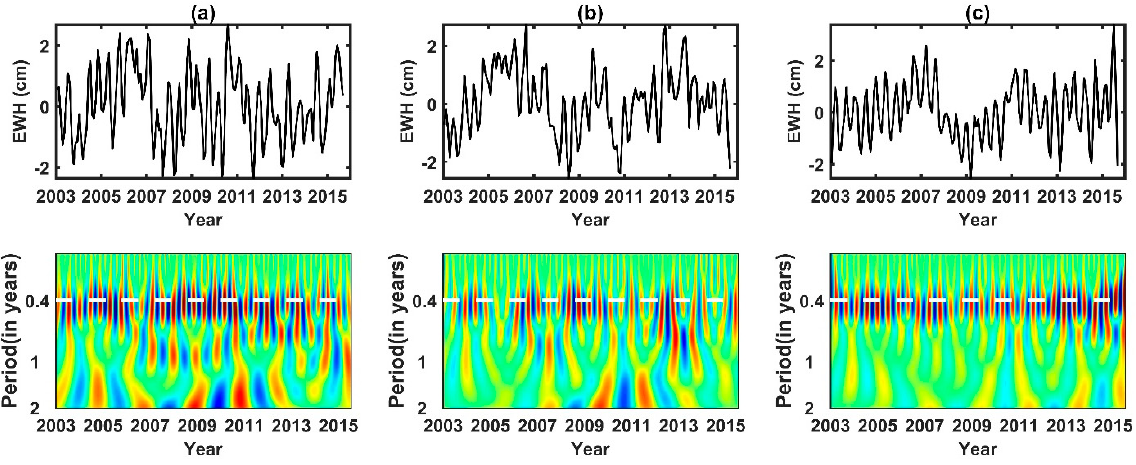
Figure 5. Time-frequency wavelet spectra of EOF Modes 2–4 (from Figure 4). Prominent signals at the quasi-periodicity of ~0.4 year or ~161.0 days are evident. ( a – c ) time series of EOF Mode 2–4 (Upper panels) and corresponding wavelet spectra (lower panels).